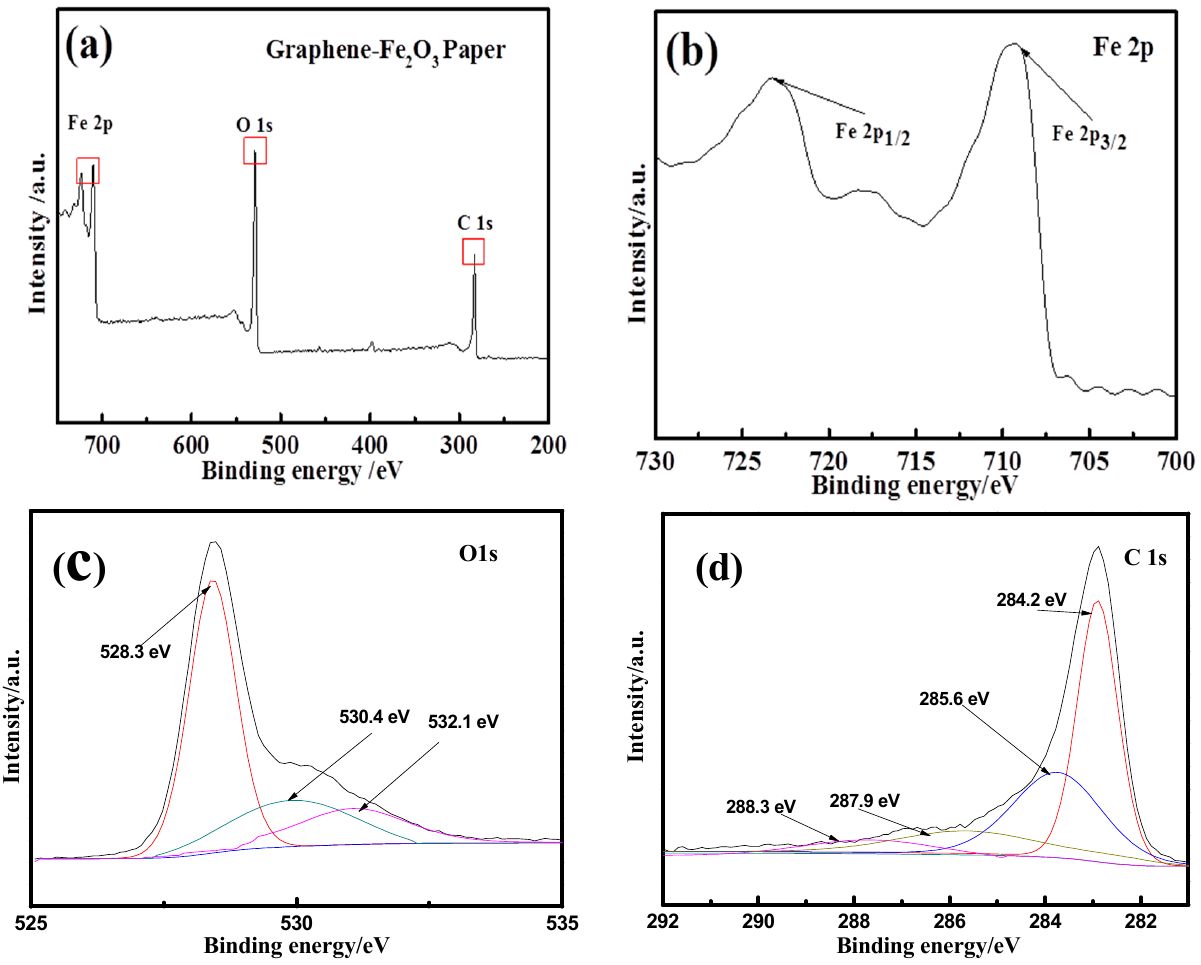
Figure 4. The XPS curves of hybrid flexible sheet ( a ) XPS spectra of the hybrid graphene-Fe 2 O 3 sheet and the homologous high-resolution spectra of ( b ) Fe 2p, ( c ) O 1s, and ( d ) C 1s. The morphology and microstructure of graphene-Fe 2 O 3 hybrid paper were investi- gated by SEM and TEM. The cross-section of the graphene-Fe 2 O 3 sheet and pure graphene paper, which were prepared by filtering the same quantity of graphene solution, is shown in Figure 5a,b, respectively. It is obviously observed that the thickness of graphene-based sheets increased from about 3.75 to 12.6 µ m owing to the insertion of Fe 2 O 3 nanoparticles between the layered graphene sheet [26]. The enlarged space of an open 3D laminated structure of graphene-Fe 2 O 3 hybrid sheet provides the electron transfer and ion transport path, which is available for Li-ion insertion/extraction, even at high rates